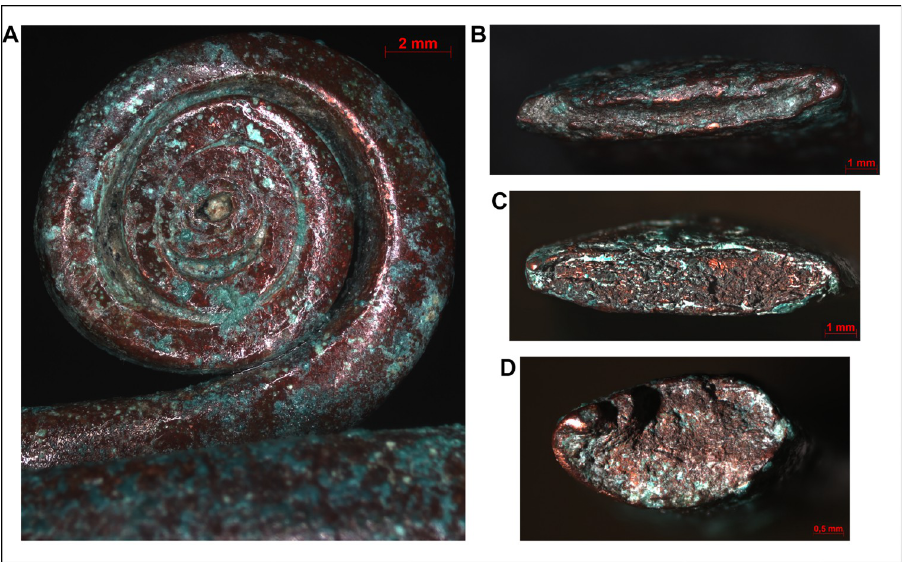
Fig 16. Micrographs showing the macrostructure of spiral bracelets. Photo: Eszter Horva´th. (A) Disk-like finial of the bracelet cut in half (O˝.2019.8.1.145.). (B) Cut end of the same segment of the bracelet cut in half showing its lentoid cross-section and laminate structure (O˝.2019.8.1.145.). (C–D) Cut and broken ends of the other segment of the bracelet cut in half showing its lentoid cross-section and laminate structure (O˝.2019.8.1.244.).